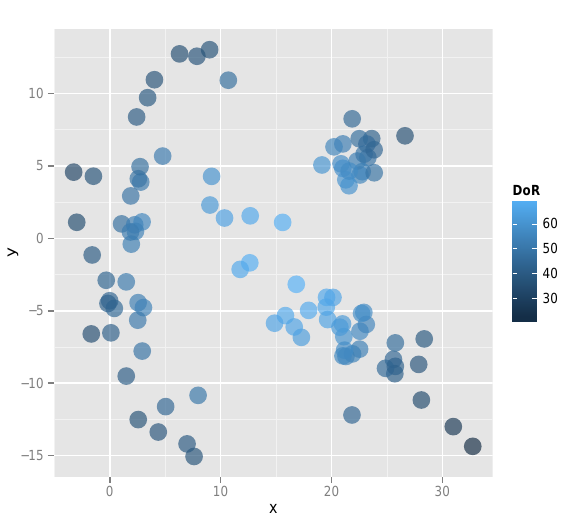
Figure 1. Example of a dataset with 120 random samples (A) and their respective DoR (B). The DoR increases in the midst of the